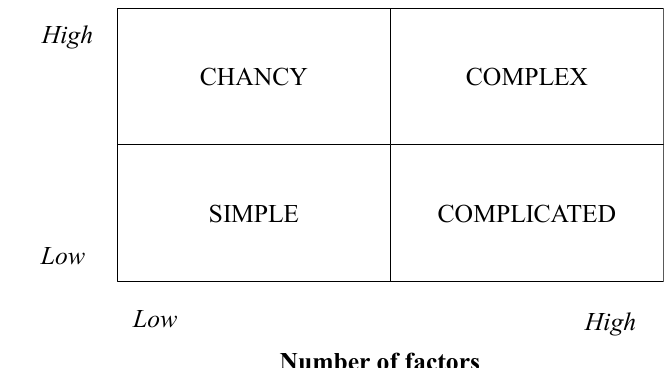
Figure 2. Types of systems distinguished, based on the dimensions of number of factors involved and level of uncertainty (based on and adapted from